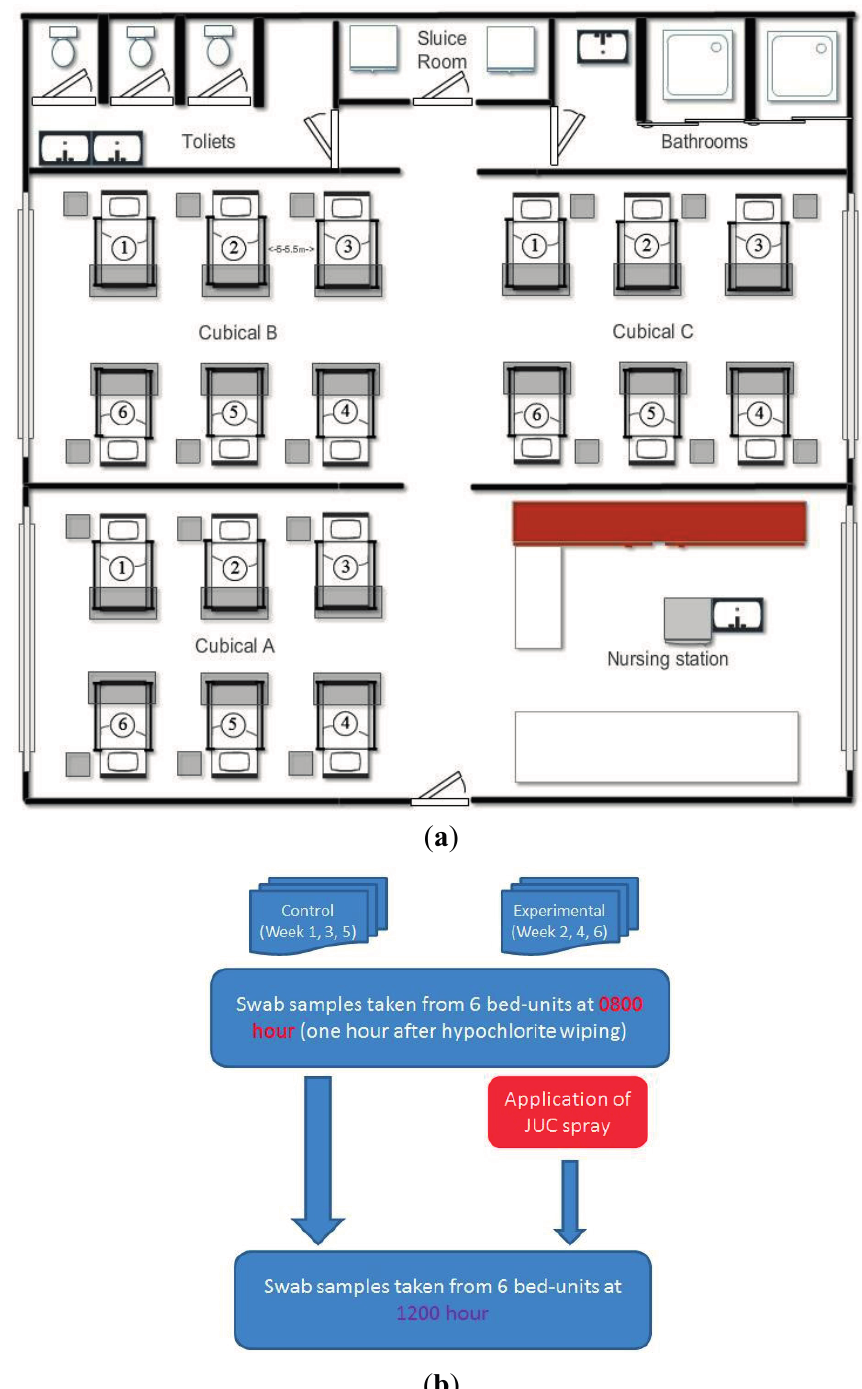
Figure 1. ( a ) Ward layout with three cubicles, and each cubicle consisting of six bed-units. Experiments and environmental sampling were conducted in Cubicle A, as it is separated from the other two cubicles and relatively remote from the sluice room, bathrooms, and toilets. On all sampling days the MRSA patients occupied Bed-unit 1 at the far end. ( b ) Experimental schedule for the study and control arms and to illustrate 6 weeks were required for the whole experiment because there was a week washing out period after each sampling day, in order to avoid the carry-over effects (if any) of the JUC